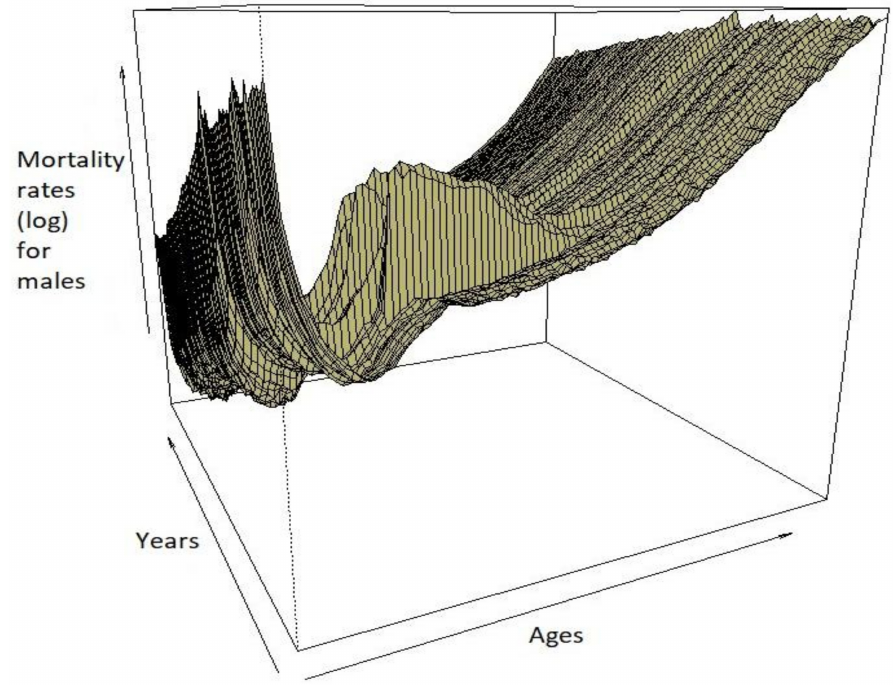
Figure 1. Evolution of mortality of French males aged 0–90 for the years 1900–2015.